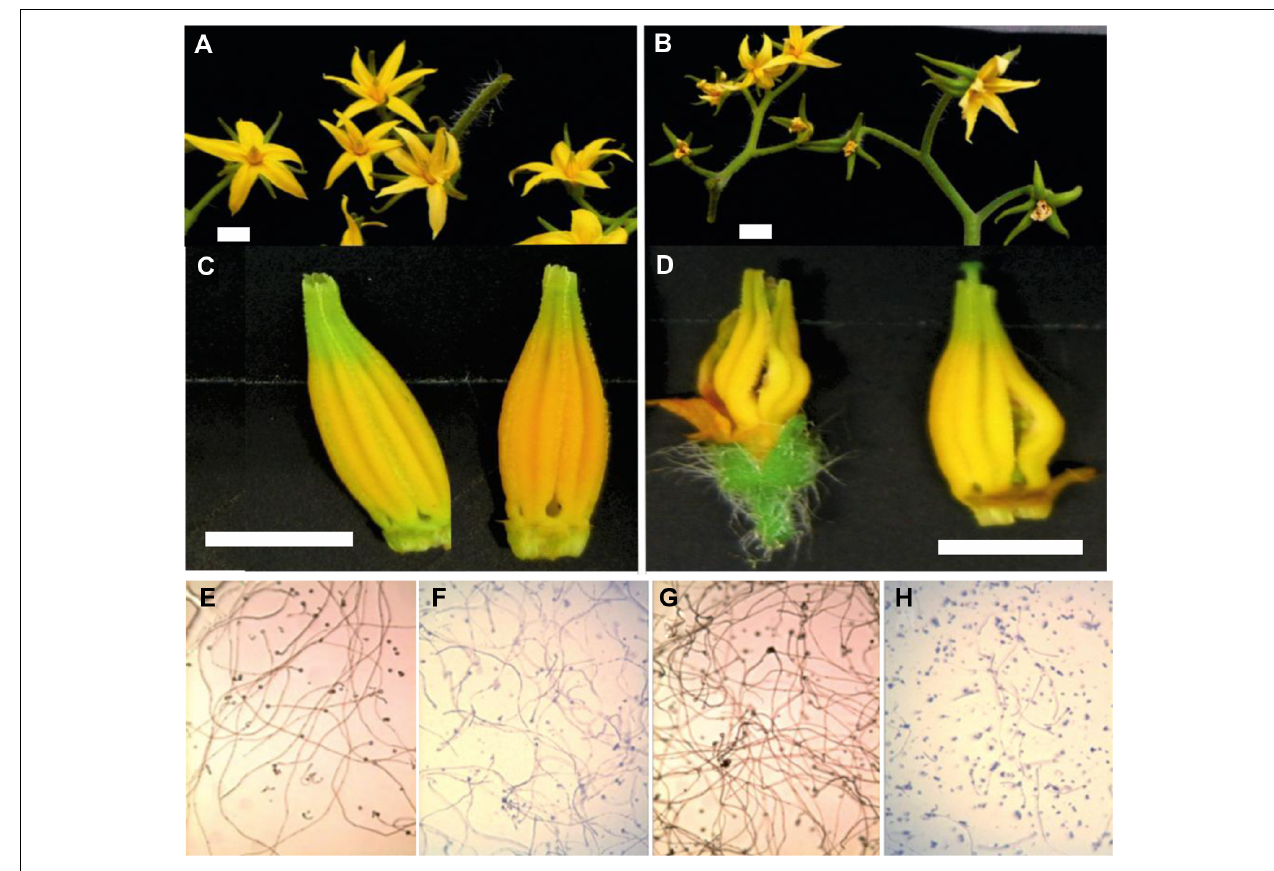
both genotypes (C) and (D) . Below (E – H) in vitro pollen germination under standard conditions ( E ; heat-tolerant genotype, G ; heat-sensitive) and high temperature for both genotypes ( F ; heat-tolerant genotype, H ;